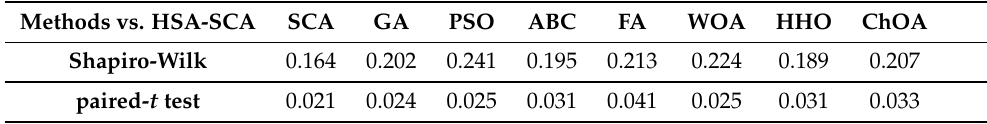
Table 5. Shapiro-Wilk scores over the mean differences between two samples as prerequisite for